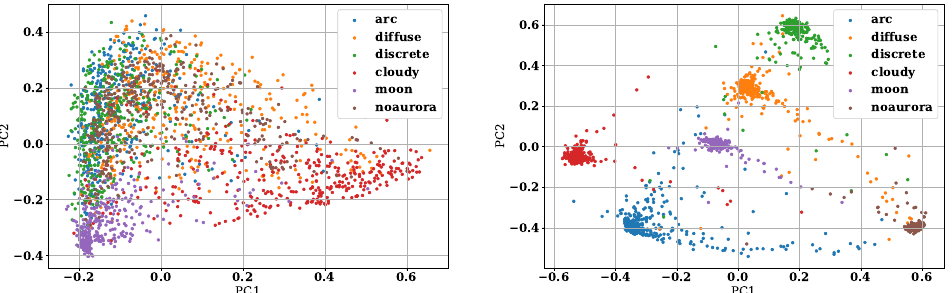
Figure 5. These are features obtained by the ArcFace model compressed to 2 dimensions. The left part shows the features of the first epoch of fold 0 and the lower part is one of epoch 45 of fold 0.